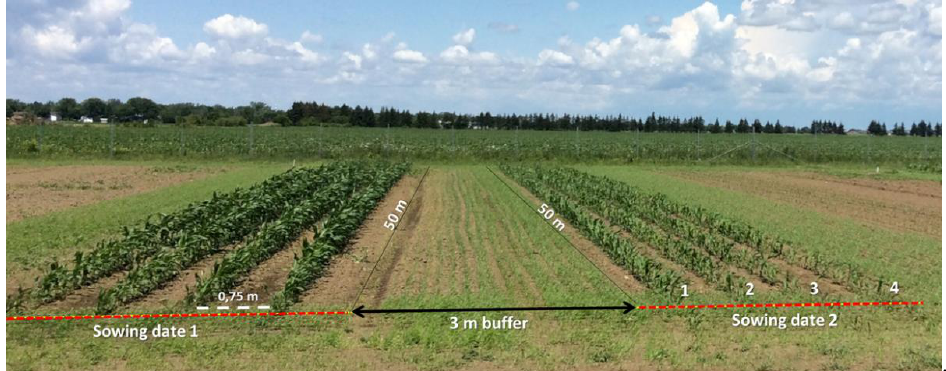
Figure 1. Example showing two of the experimental plot layouts. During the experiment, a weekly ground truth campaign was conducted at the same time as the image acquisition. Each ground reference was randomly selected and con- sisted of two row sections with ten consecutive corn plants each. Only the two middle rows of each plot were used to avoid border effects. The first and the tenth plants of each row-section were identified with a golf tee positioned next to them. After image acquisi- tion, the ten (10) sampled plants of each row were clipped at ground level and weighed individually using a high-precision balance to determine the fresh biomass. The samples were then dried at 70 °C for a minimum of 5 days, and weighed again to get the dry bio- mass.